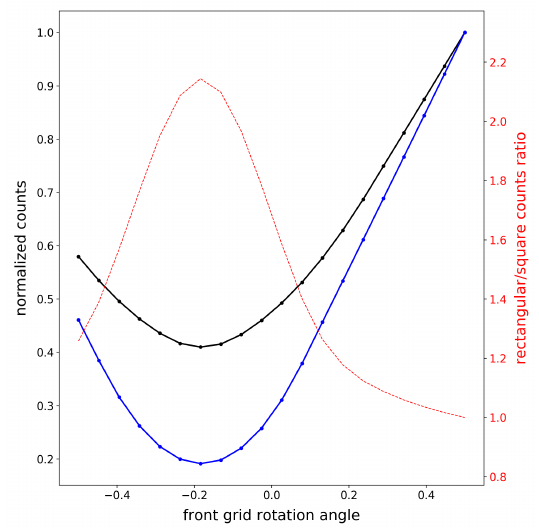
Figure 12. Changes of signal measured in the stripe C taking into account misalignment (rotation) of the first grid of collimator#18 (finest one). Black line presents rectangular grids, blue line is for square grids, and red line presents signals